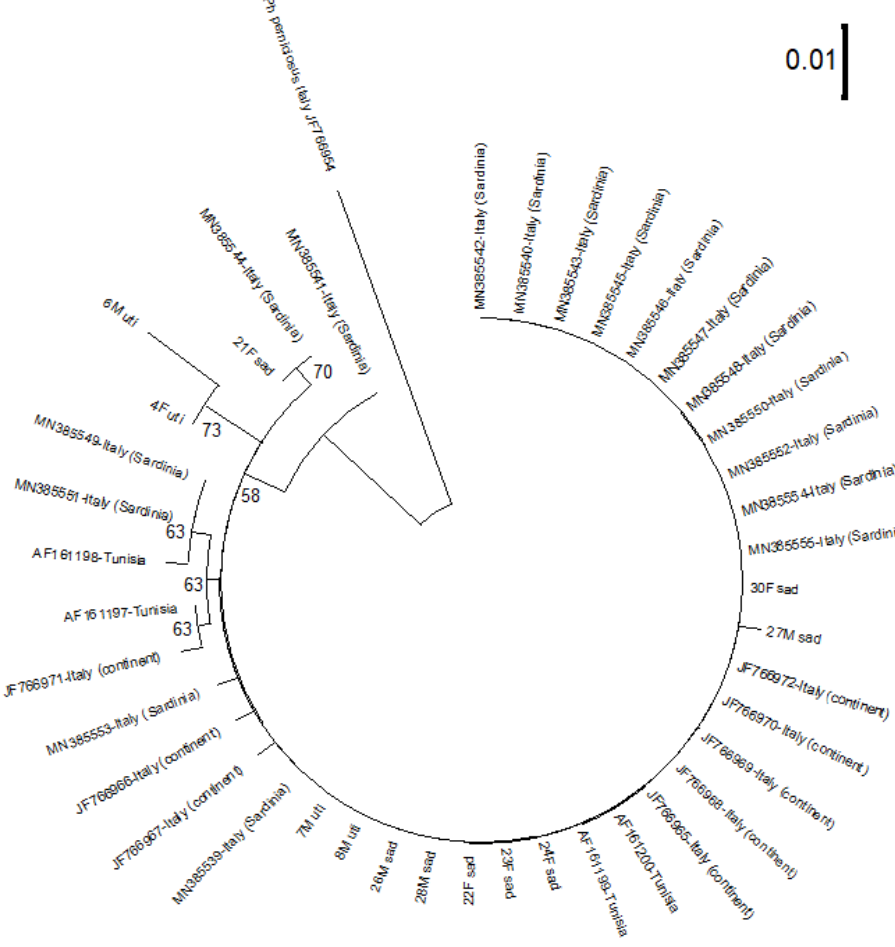
Figure 4. Maximum likelihood tree obtained using a Hasegawa-Kishino-Yano model on a dataset of cytochrome b mtDNA sequences. Ph. perfiliewi collected from the sites of Saddaguia (sad) and Utique (uti) and processed in the present study are compared with available sequences in Genbank after rooting on Ph. perniciosus . The tree topology was supported by 1000 Bootstrap replicates. Bootstrap values >50% indicated close to the considered nodes.